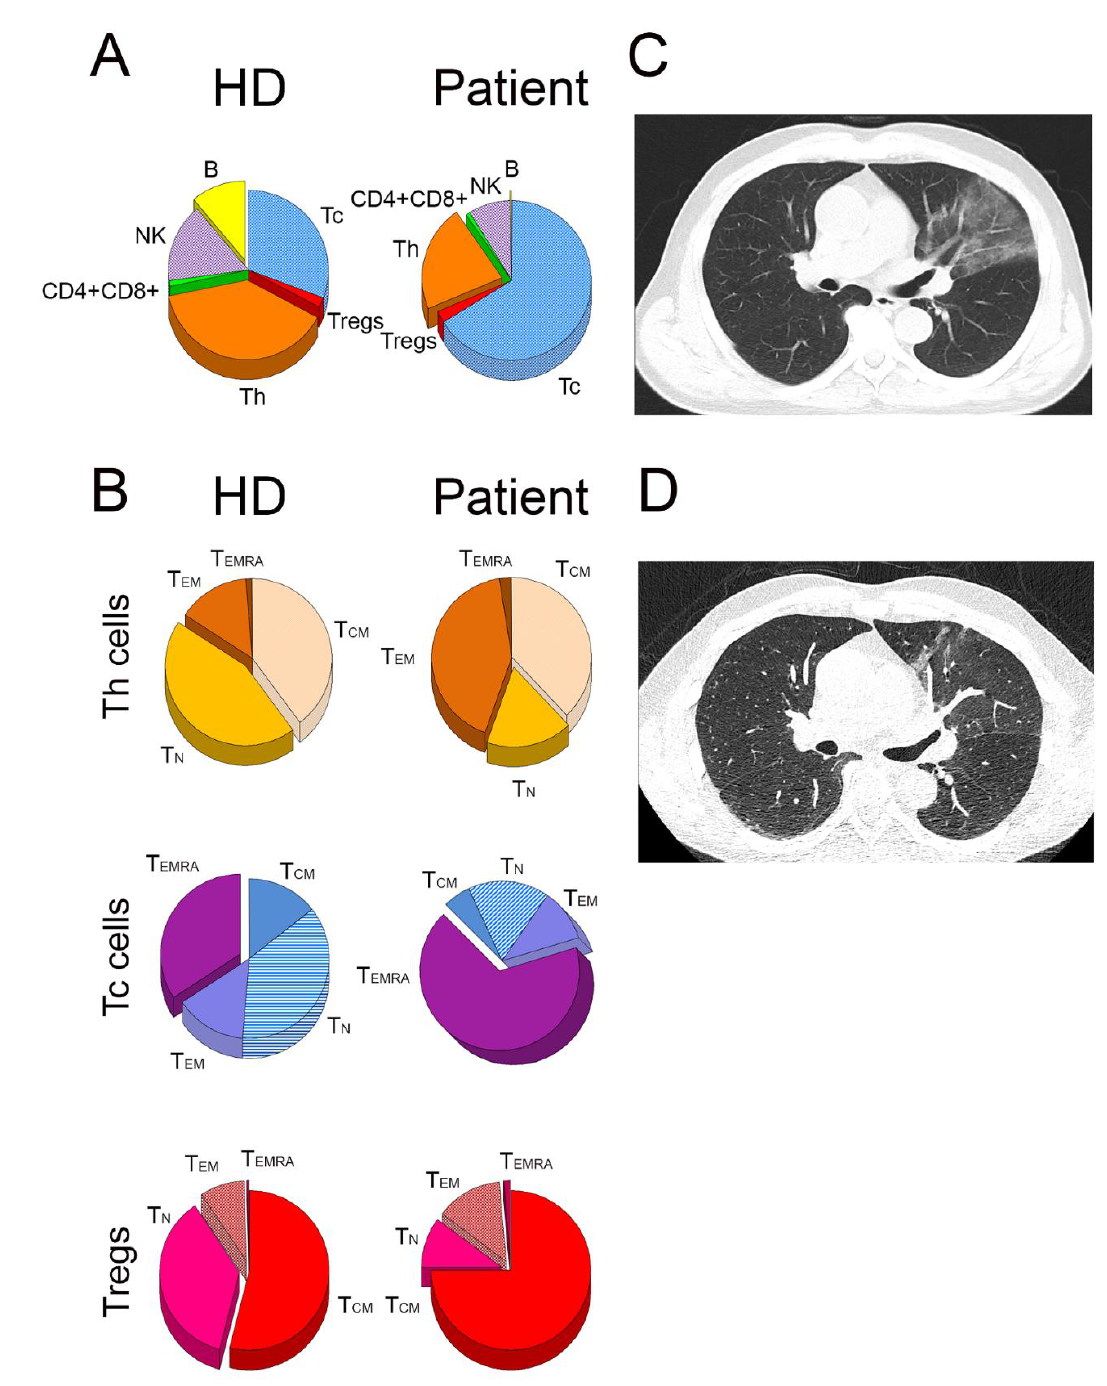
Figure 2. ( A ) Depicts the distribution of the following lymphocyte subsets: Tc, Th, Tregs, CD4 + CD8+ (double positive) T cells, B and natural killer cells in the healthy donors (HD) and in the patient. ( B ) Depicts the proportions of naive (TN), central memory (TCM), effector memory (TEM), and effector memory T cells that re-expressed CD45RA (TTEMRA) within Th, Tc, and Treg cell populations. The right panel depicts the high-resolution computed tomography chest scans at day 79 ( C ; interstitial pneumonia) and at day 118 ( D ; complete remission).